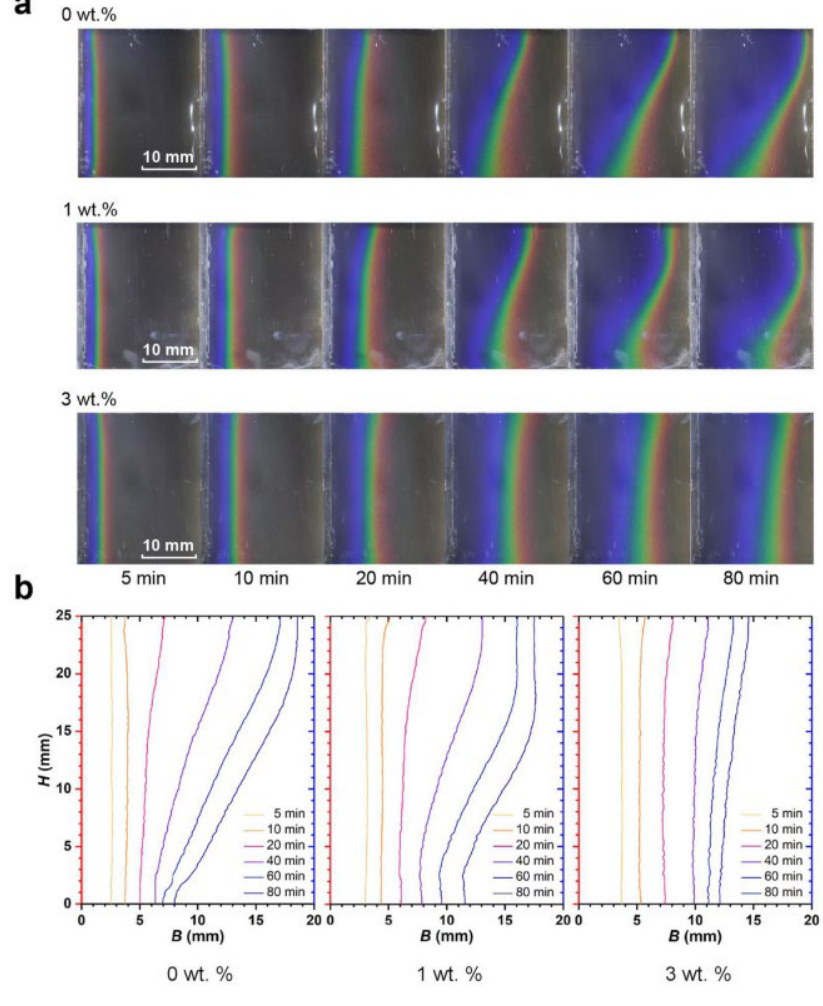
Figure 28. Phenomenological changes in the H/B = 1.25 rectangular cavity during melting of several NePCM samples: ( a ) TLC thermography snapshots collected at representative times and ( b ) comparison of the thermal images’ melting front. Reprinted with permission from Ref. [49]. 2020, Elsevier.